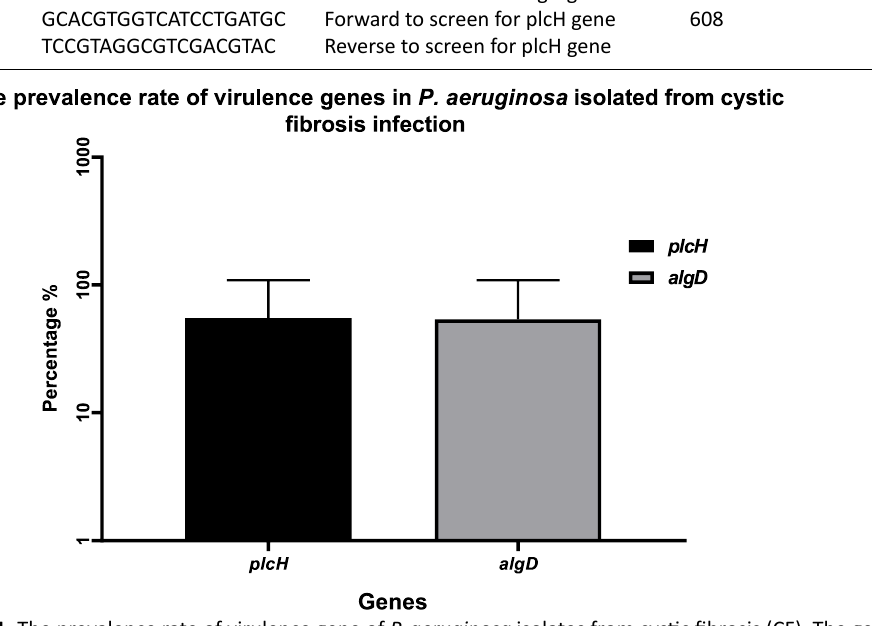
Fig. 1. The prevalence rate of virulence gene of P. aeruginosa isolates from cystic fibrosis (CF). The gene algD and plcH were detected in P. aeruginosa strains at a rate of